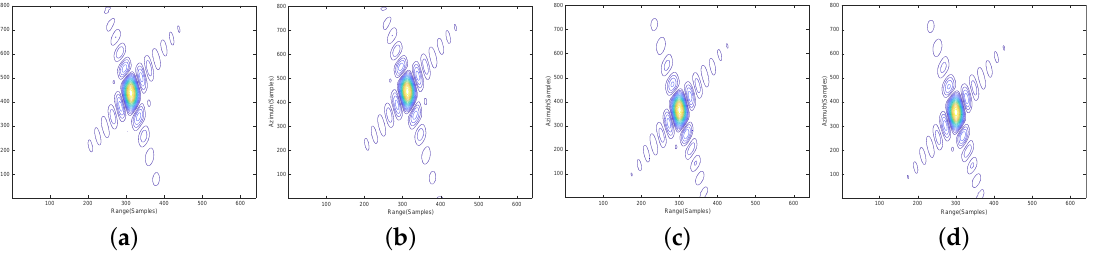
Figure 9. Imaging results of the NLCS-based 2-D SVD algorithm with accurate movement information. ( a ) P 1 . ( b ) P 2 . ( c ) P 3 . ( d ) P 4 .